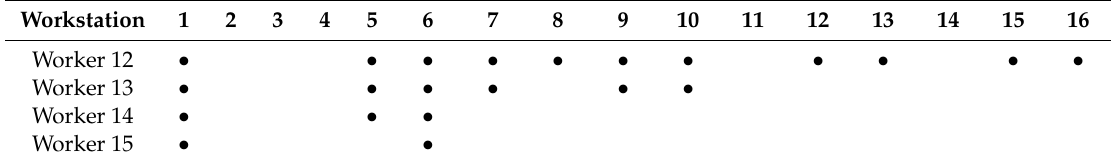
Table 4. Penalized assignments as a result of limitations of the workers’ capacities and job